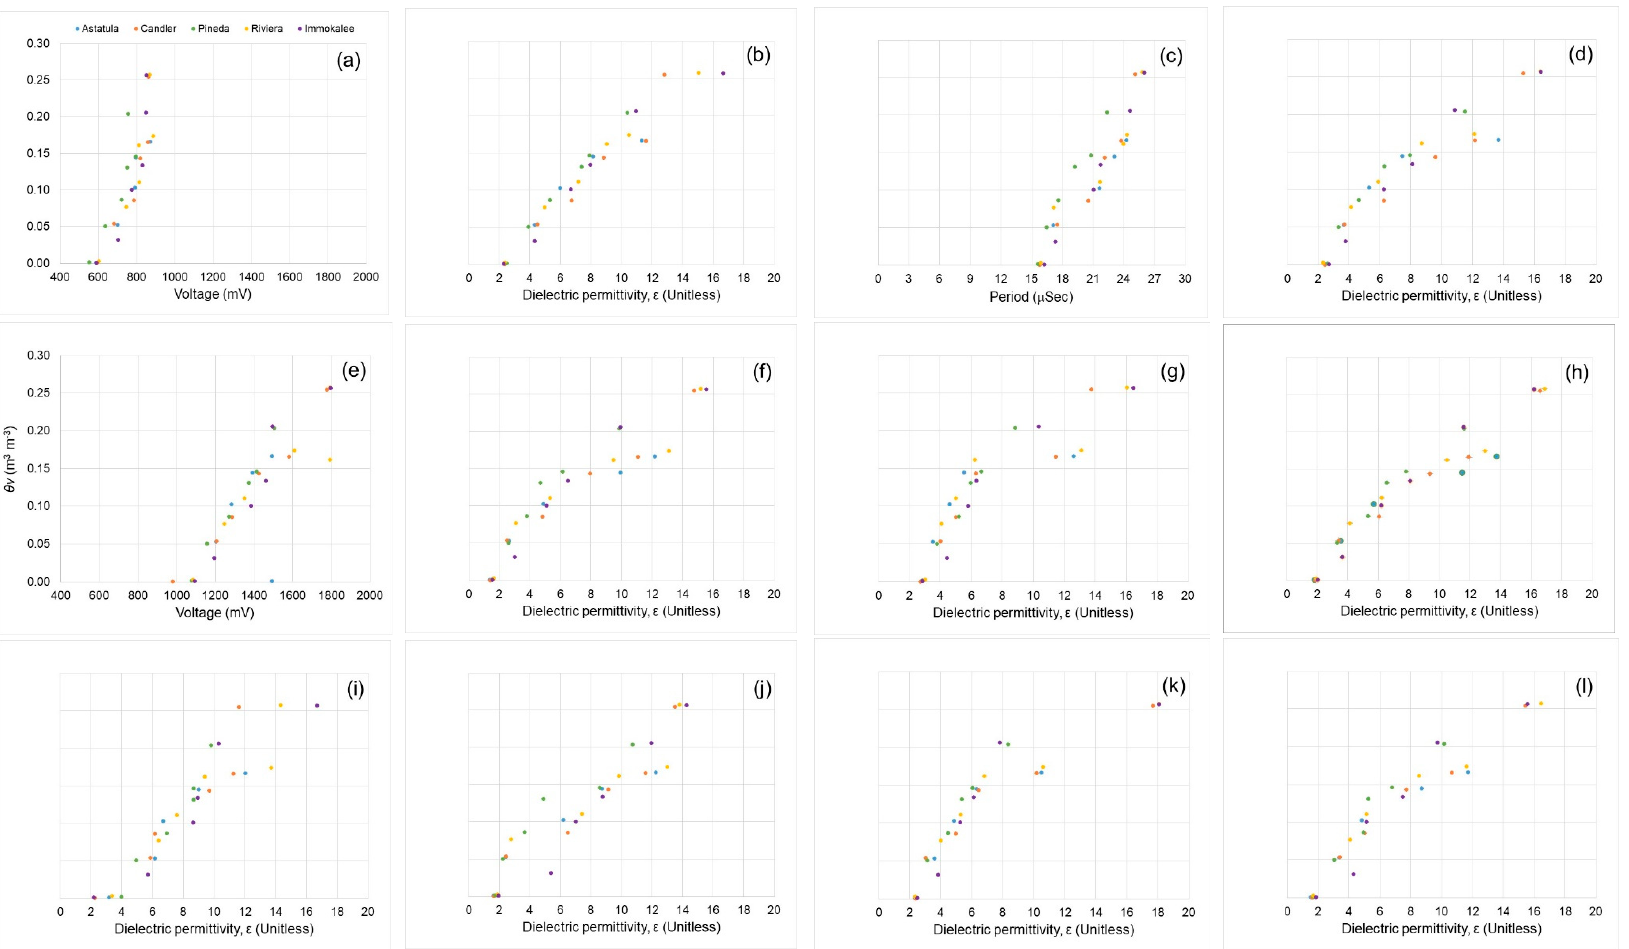
Figure 7. Raw values measured by all commercial soil moisture sensors in the soil bottom layer (0.3–0.6 m): 10HS ( a ), 5TE ( b ), CS616 ( c ), TDR315 ( d ), GS1 ( e ), CS655 ( f ), Hydra Probe ( g ), TDR315L ( h ), GS3 ( i ), CS650 ( j ), TDT-ACC-SEN-SDI ( k ), and TDR310S ( l ). Each data point is the average of the three samples of the soils taken from each of the three replications by soil series ( n = 9).